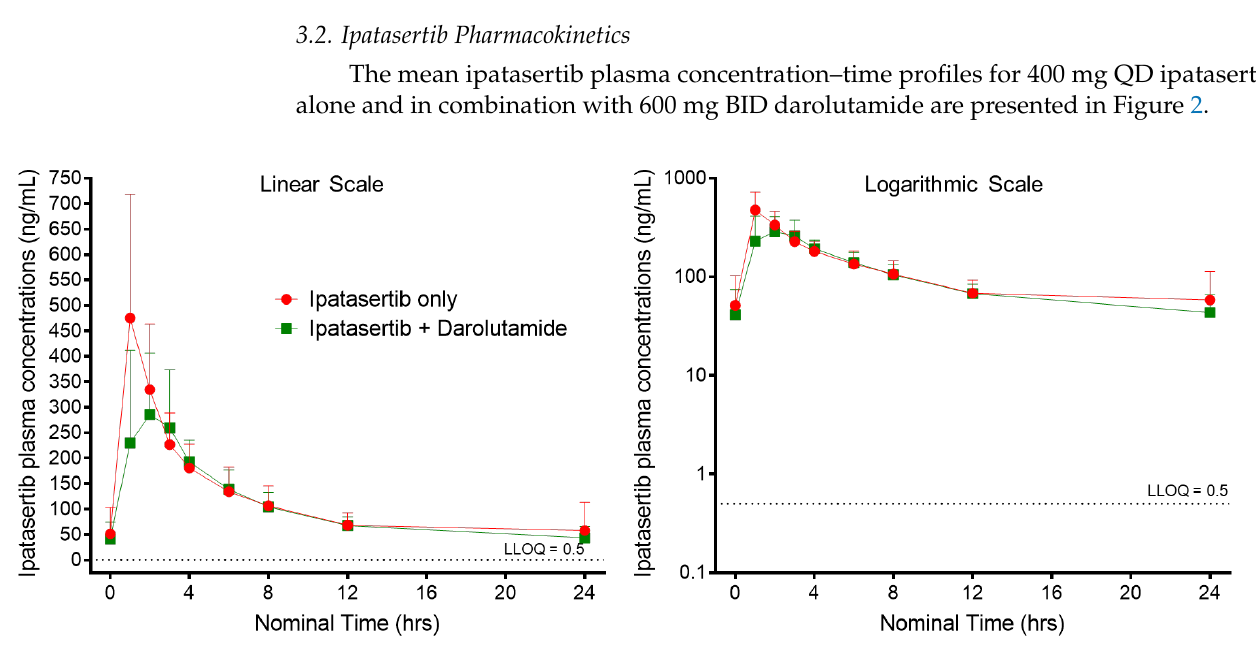
Figure 2. Arithmetic Mean ± SD concentration–time profiles of ipatasertib presented as both linear and logarithmic scales following multiple-dose oral administration of ipatasertib 400 mg QD alone and in combination with darolutamide 600 mg BID.